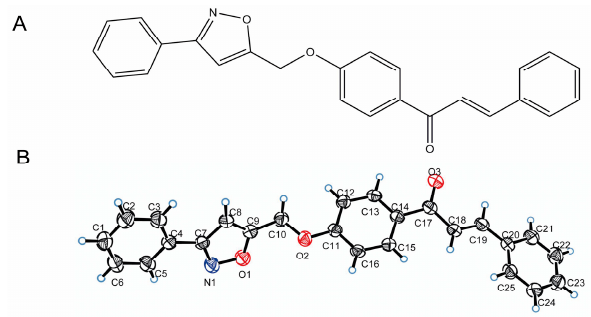
Figure 1. Chemical and crystal structure of PMPP. ( A ) Chemical structure of PMPP; ( B ) Crystal structure of